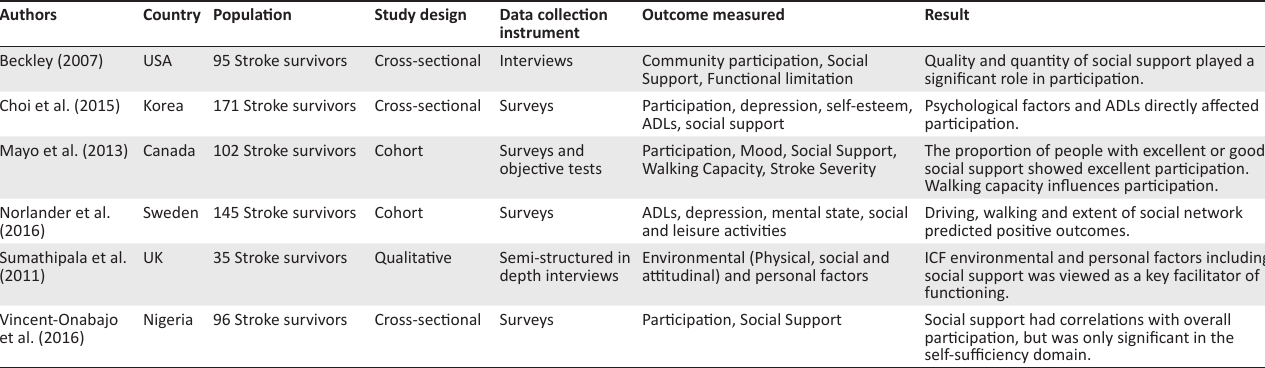
TABLE 1: Articles that were reviewed and met the criteria for the study. Authors